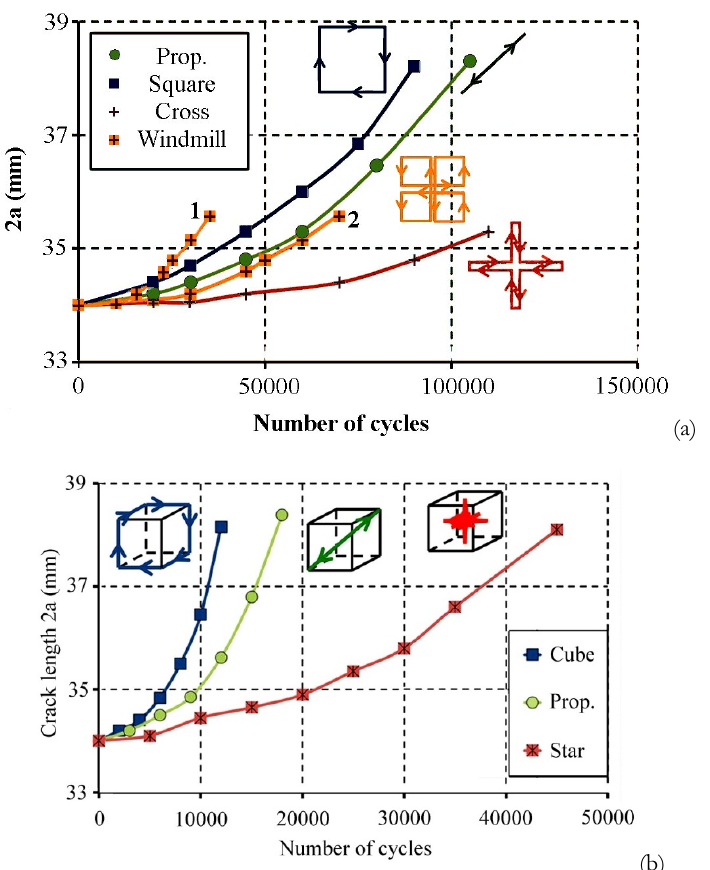
Figure 5: (a) Evolutions of the crack lengths with the number of cycles applied for each load case in mixed mode I+II conditions. Two curves are plotted for the « windmill » load path, the curve 1, was plotted considering 1 cycle per load path, and the curve 2 considering 2 cycles per load path. (b) Evolutions of the crack lengths with the number of cycles applied for each load case in mixed mode I+II+III